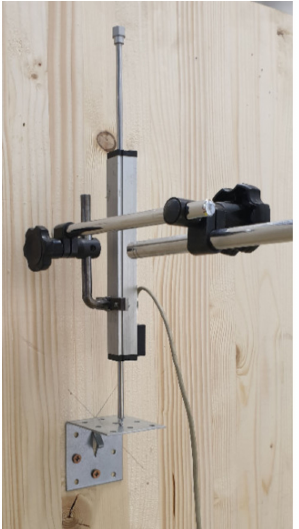
Figure 4. Displacement tracer—sensor from company Ahlborn [42].